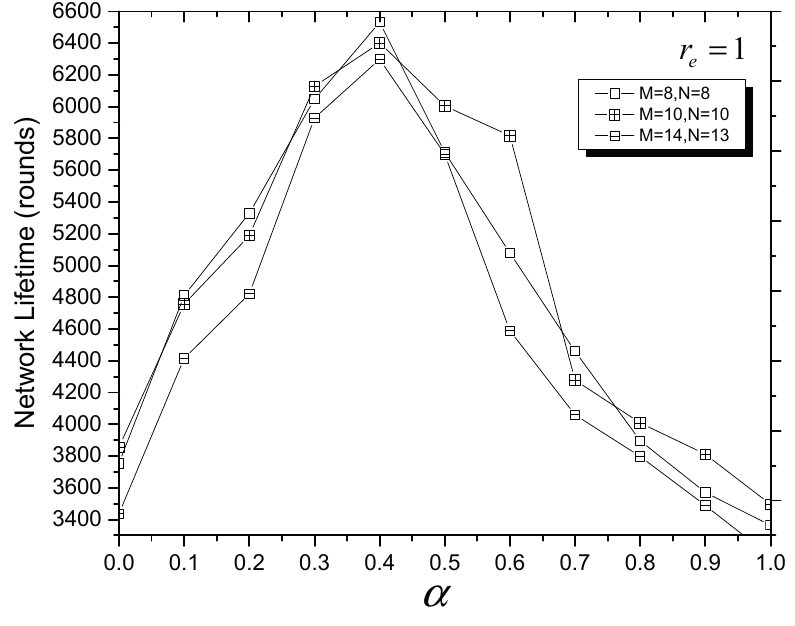
Figure 5. Average SCD versus different values of r